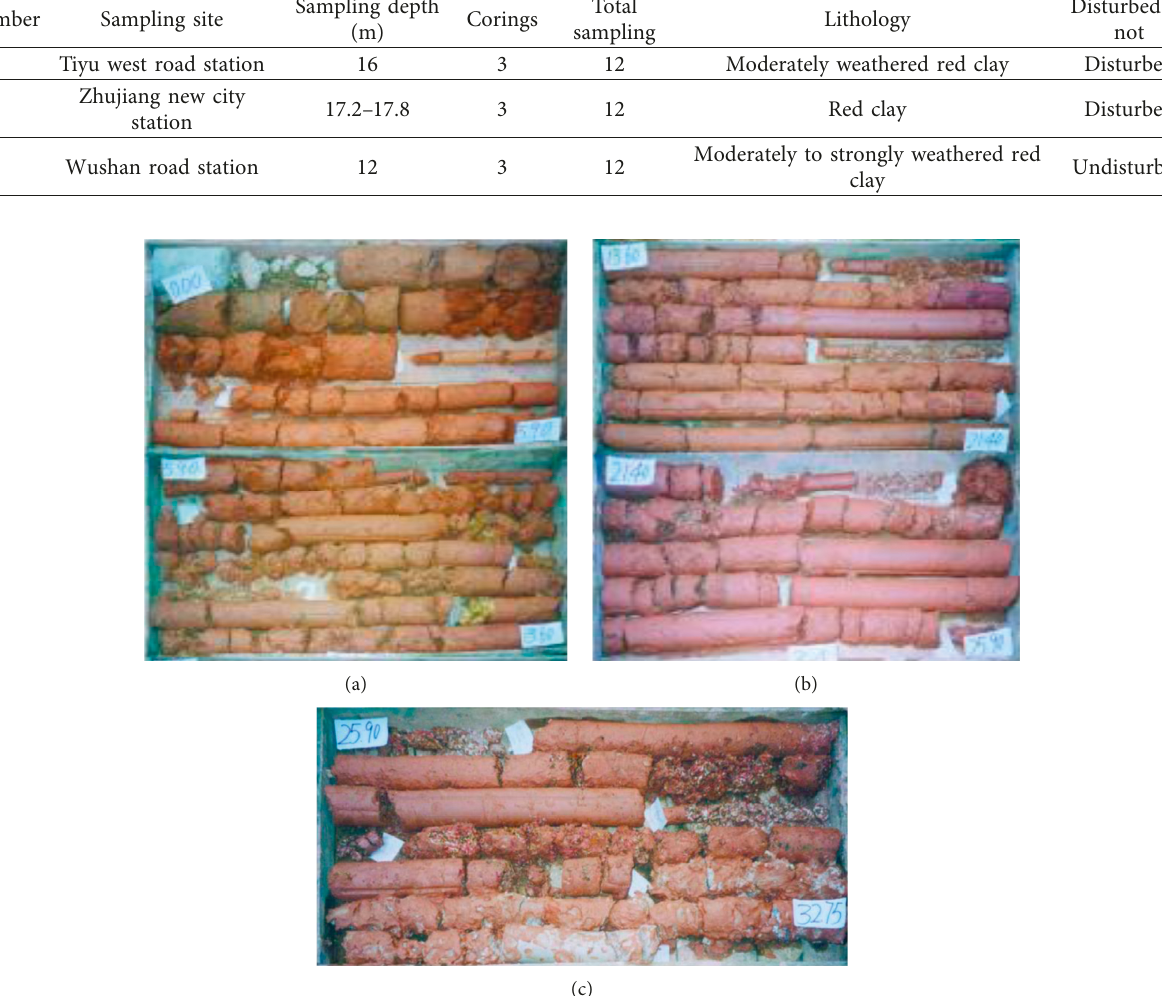
Figure 2: Corings of Wushan road station in Guangzhou Metro Line